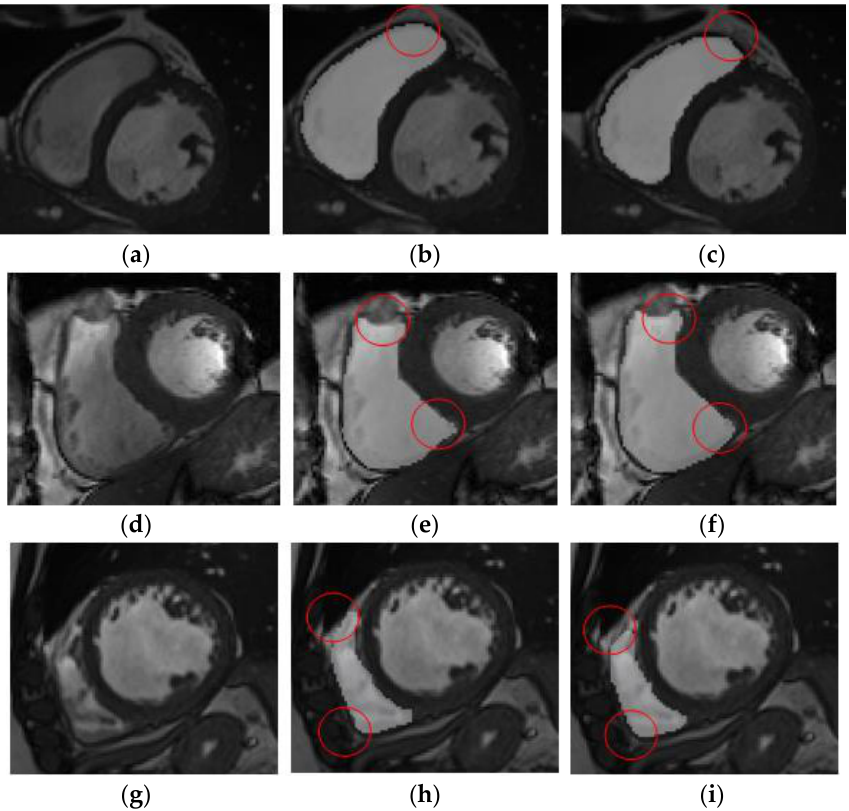
Figure 5. Comparison of network segmentation results. ( a ) The input feature image. ( b ) The resulting images of the U-Net network segmentation. ( c ) The gold-standard image marked by experts. ( d ) The input feature image. ( e ) The resulting images of the U-Net network segmentation. ( f ) The gold-standard image marked by experts. ( g ) The input feature image. ( h ) The resulting images of the U-Net network segmentation. ( i ) The gold-standard image marked by experts.